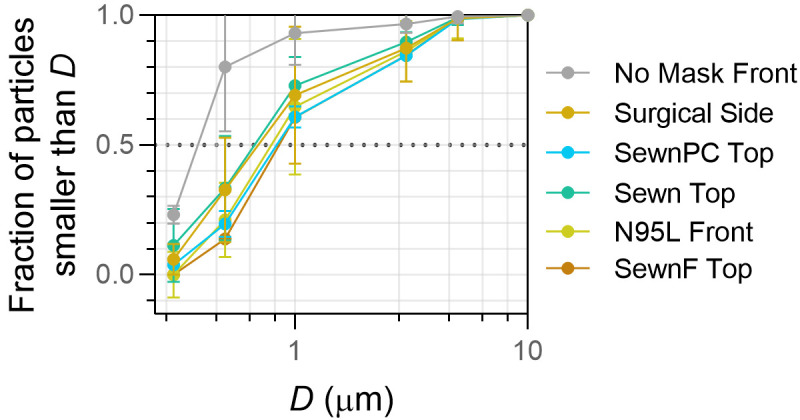
Background-corrected cumulative size distributions comparing distributions at vulnerable positions for each facemask in the enclosed box environment.Vulnerable positions include: Side (Surgical mask), Front (No Mask, N95L), and Top (sewn masks, N95T). Diameter (D) obtained from upper bin size and reported in μm. Error bars represent standard deviation for particle counts in each of the respective particle size bins from three independent measurements.